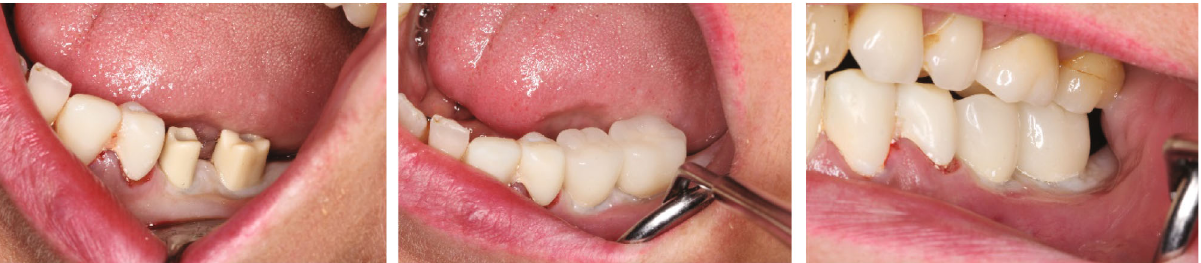
Figure 14: Fitting the long-term temporary restorations.